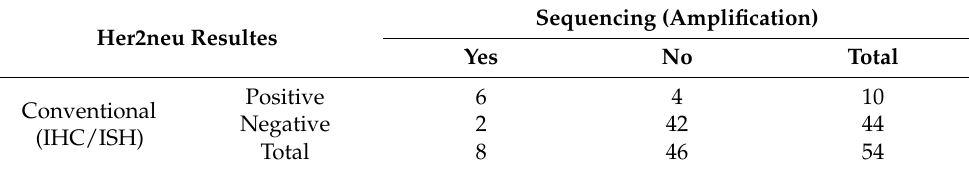
Figure 3. The proportion of Her2neu tested patients was divided into positive (IHC 3+ and IHC 2 with overamplification in ISH), negative (IHC 0; 1 and 2+ if ISH shows no overamplification) and unknown if no result was obtained. Table 2. Comparison of conventional Her2neu diagnosis based on IHC/ISH with results of